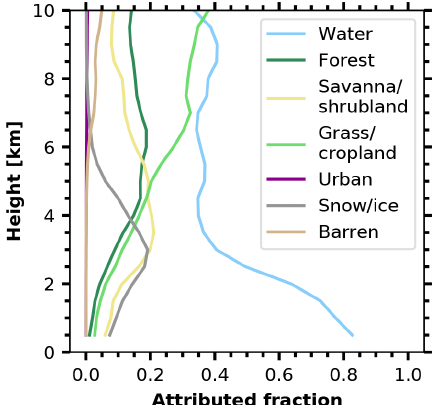
Figure 8. Fraction of residence time below the reception height (2km) above different possible aerosol source regions based on a FLEXPART